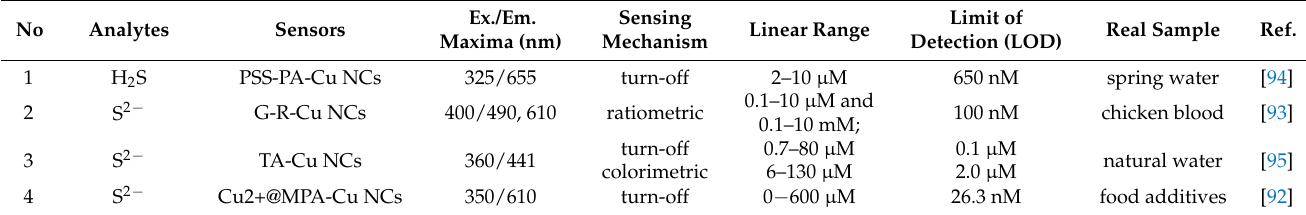
Table 3. List of fluorescent probes based on Cu NCs for sulfide anions